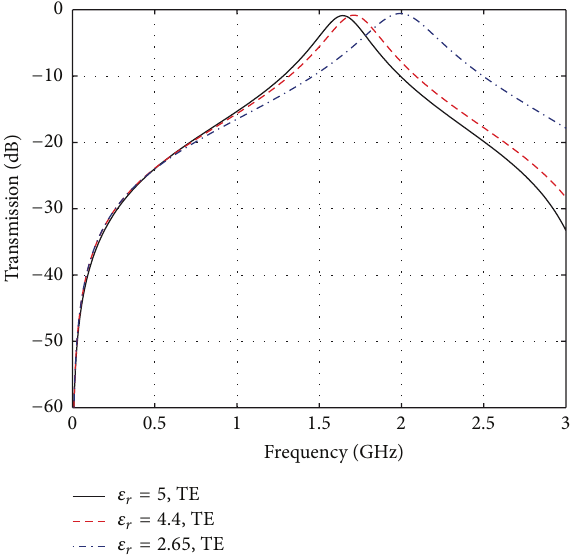
Figure 8: Transmission coefficients of designed